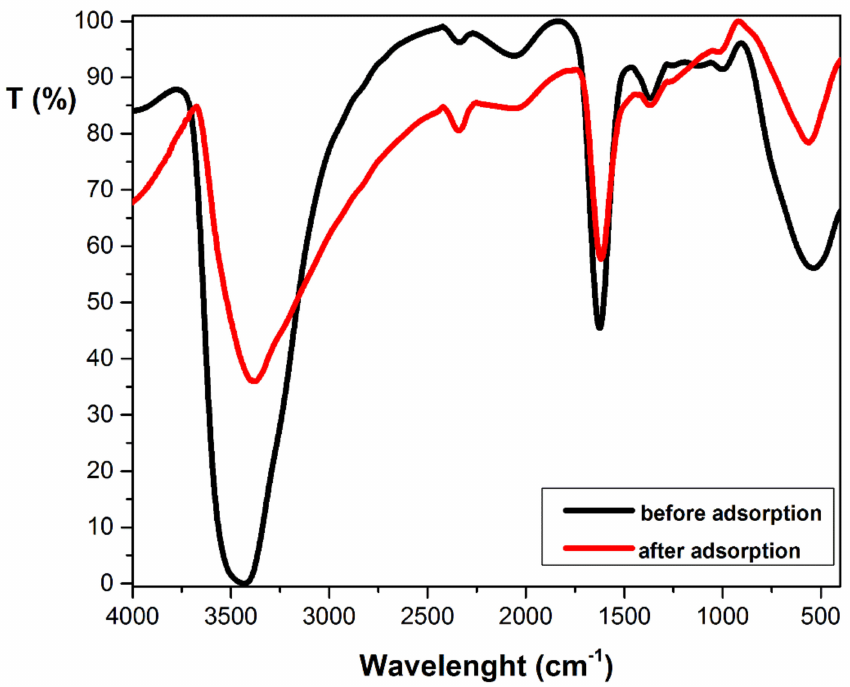
Figure 2. FTIR spectrum of Bathurst burr powder before and after crystal violet adsorption. [adsorp- tion conditions: pH 7; initial dye concentration: 100 mg · L − 1 ; contact time: 30 min; adsorbent dose: 2 g · L − 1 ; temperature: 294 K, ionic strength: 0 mol L − 1 ]. Table 2. The FTIR bands that were assigned to different cellulose and hemicellulose. FTIR